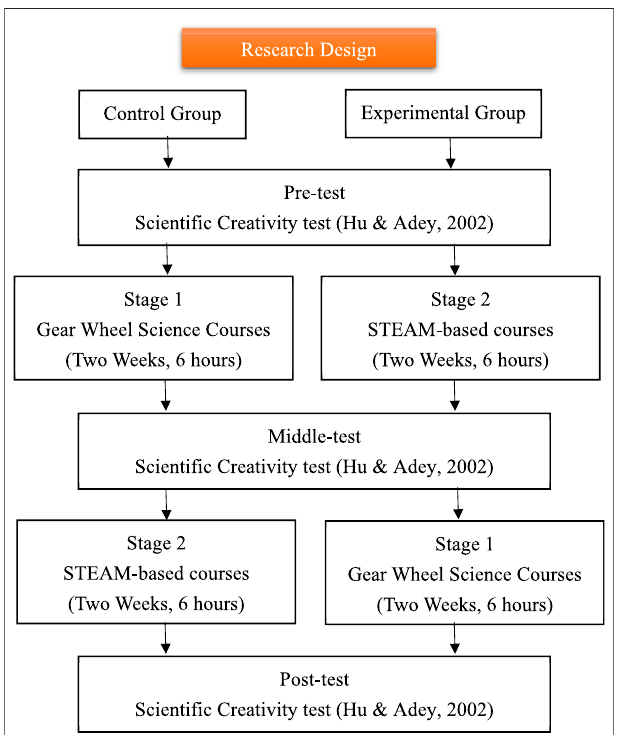
FIGURE 3 | Research Design Structure of this study.